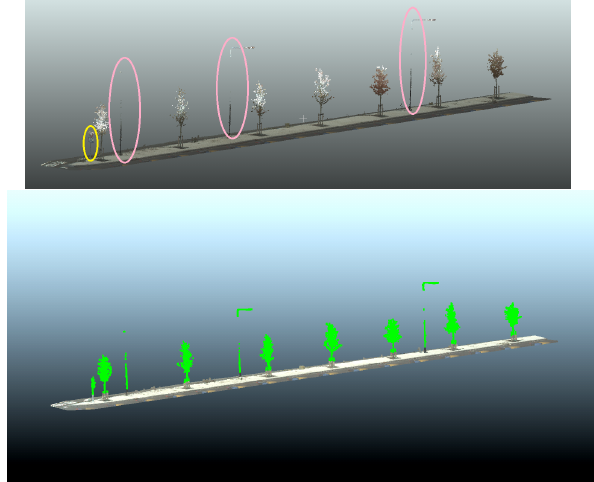
Figure 5: Top; a sub-section of the MLS point cloud having trees, light poles and traffic signs in the same row (light poles and traffic signs are shown with circles). Bottom; tree classification result of the same sub-section, which also holds the false detection of light poles and traffic signs (tree class is indicated by green color).